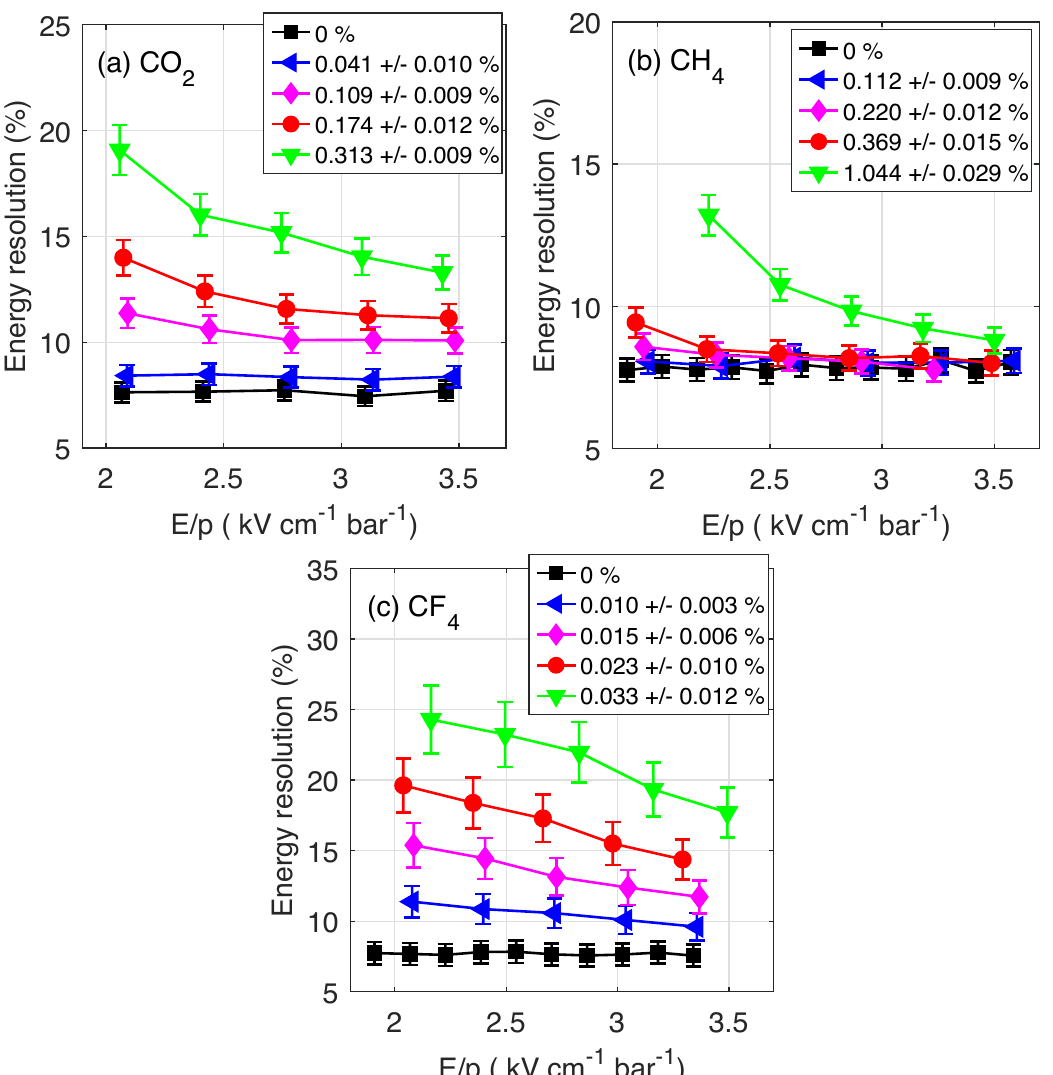
Figure 4 . Energy resolution for 5.9 keV x-rays absorbed in the driftless GPSC as a function of E=p , for mixtures of Xe with various molecular additives at di(cid:11)erent concentrations: (a) CO 2 ; (b) CH 4 ; (c) CF 4 . Total pressures of 1.13, 1.25 and 1.24 bar were used, in average, for Xe-CO 2 , Xe-CH 4 and Xe-CF 4 mixtures, respectively. The solid lines serve only to guide the